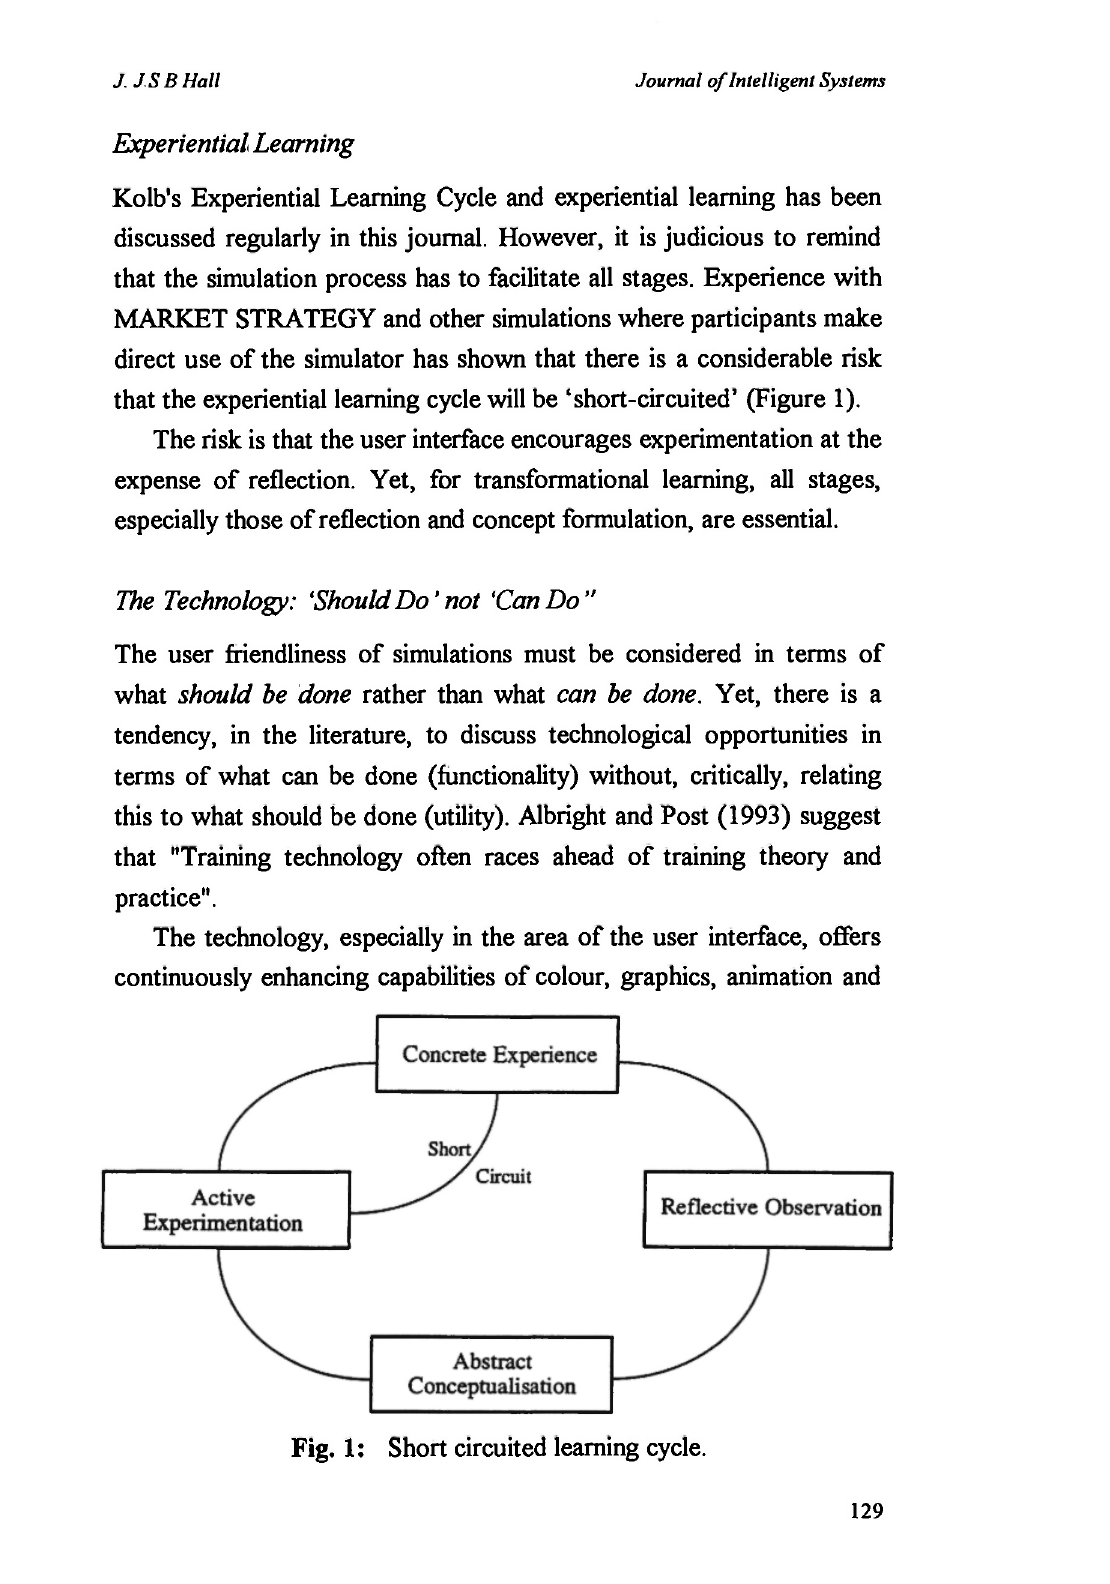
Fig. 1: Short circuited learning